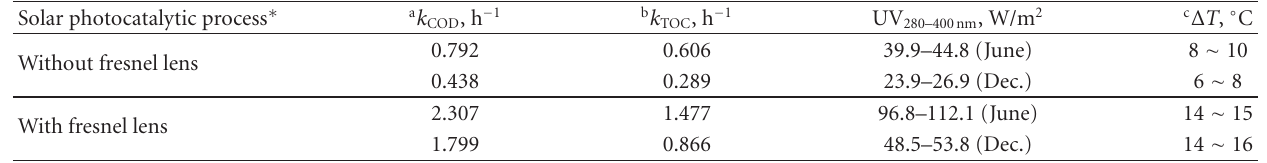
Table 4: E ff ect of Fresnel lens on the degradation rate constant of AO10 wastewater. Solar photocatalytic process ∗